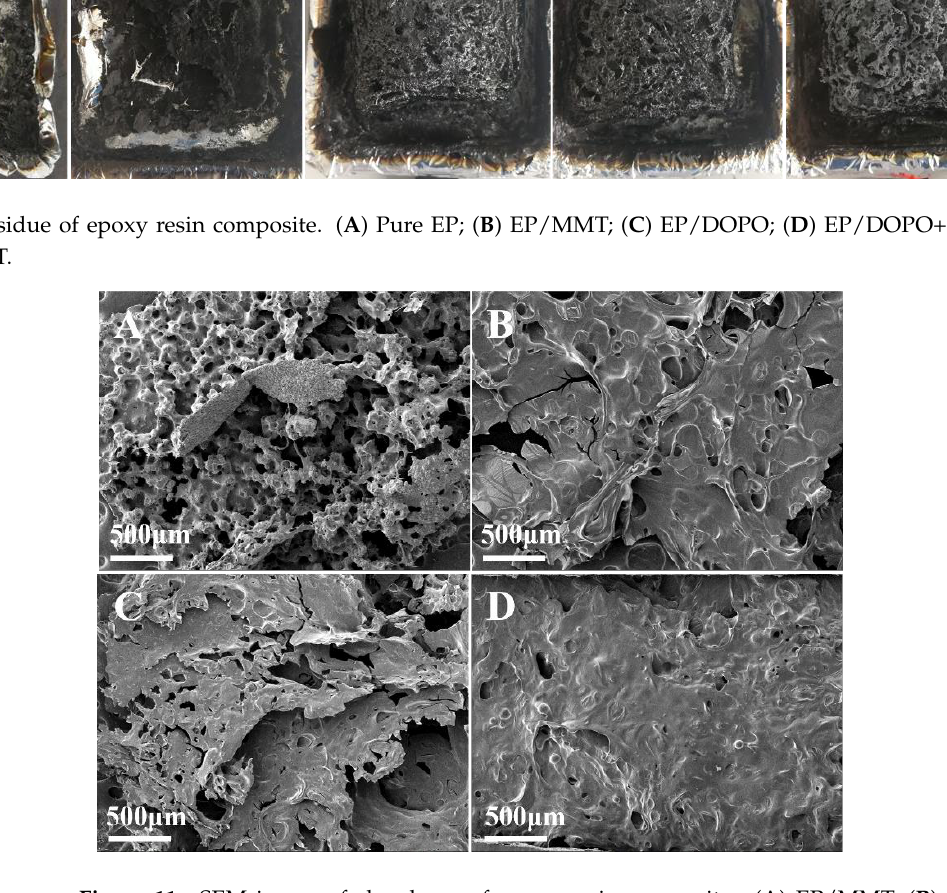
Figure 10. Char residue of epoxy resin composite. ( A ) Pure EP; ( B ) EP/ MMT; ( C ) EP/DOPO; ( D ) EP/DOPO+MMT; ( E ) EP/DOPO-MMT.